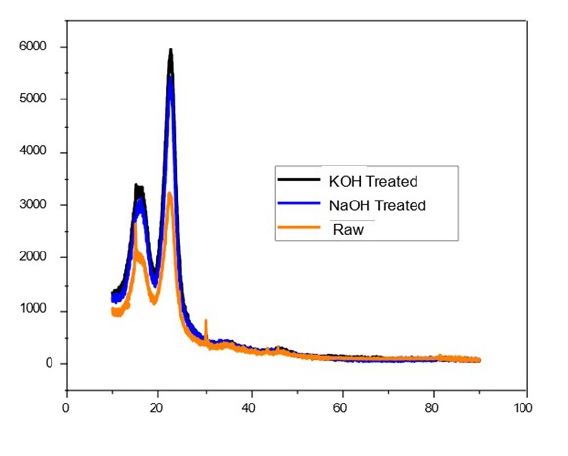
Fig. 5. XRD spectra of raw and alkali treated PFs.